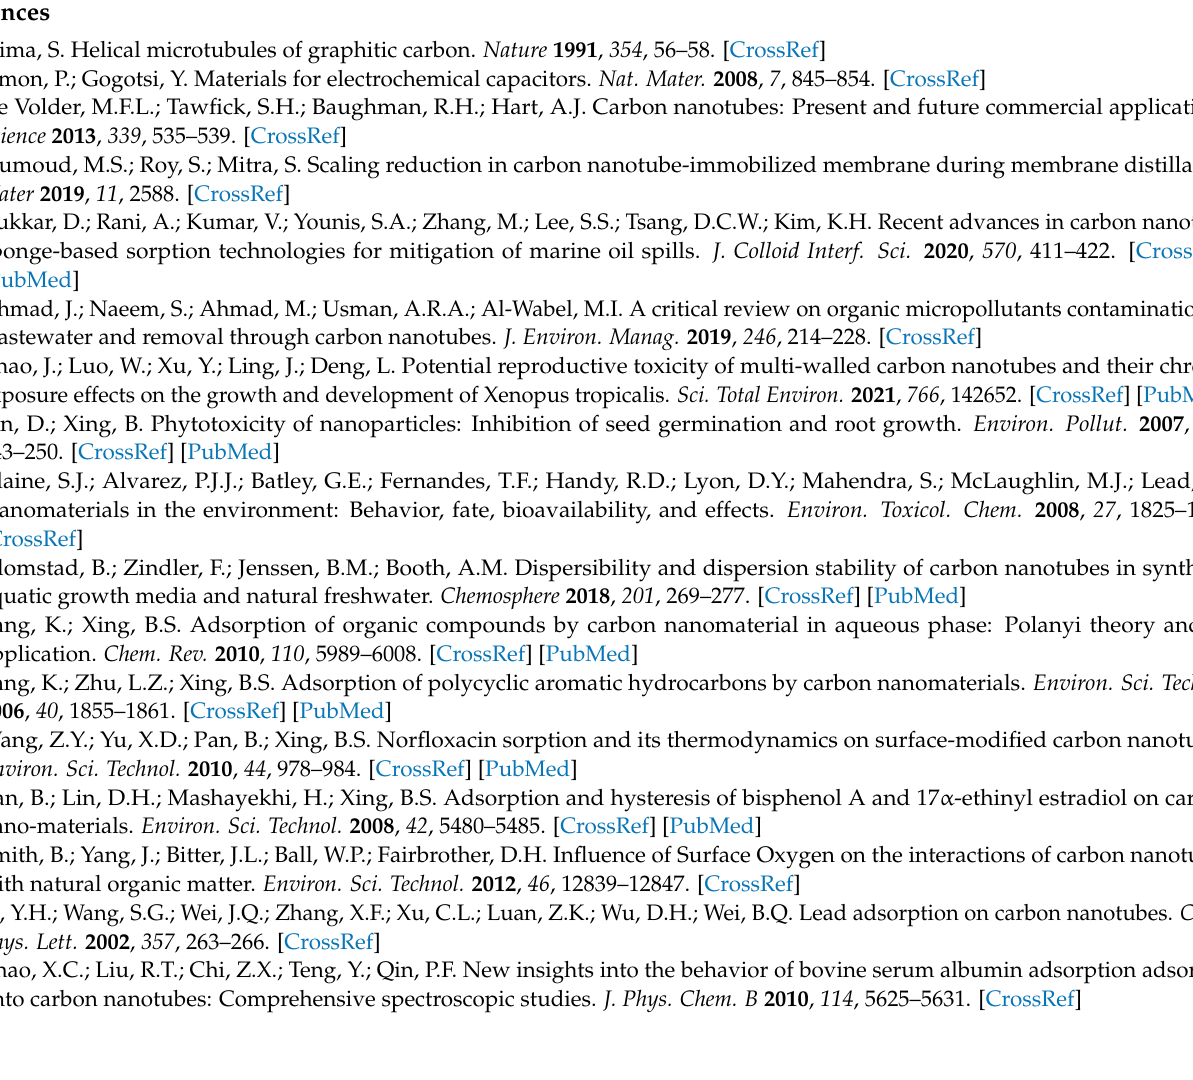
1 h settlement. Figure S5: Photo of three functionalized MWCNT suspensions with different initial concentration of nitrobenzene, after 72 h of shaking and 5 minutes of